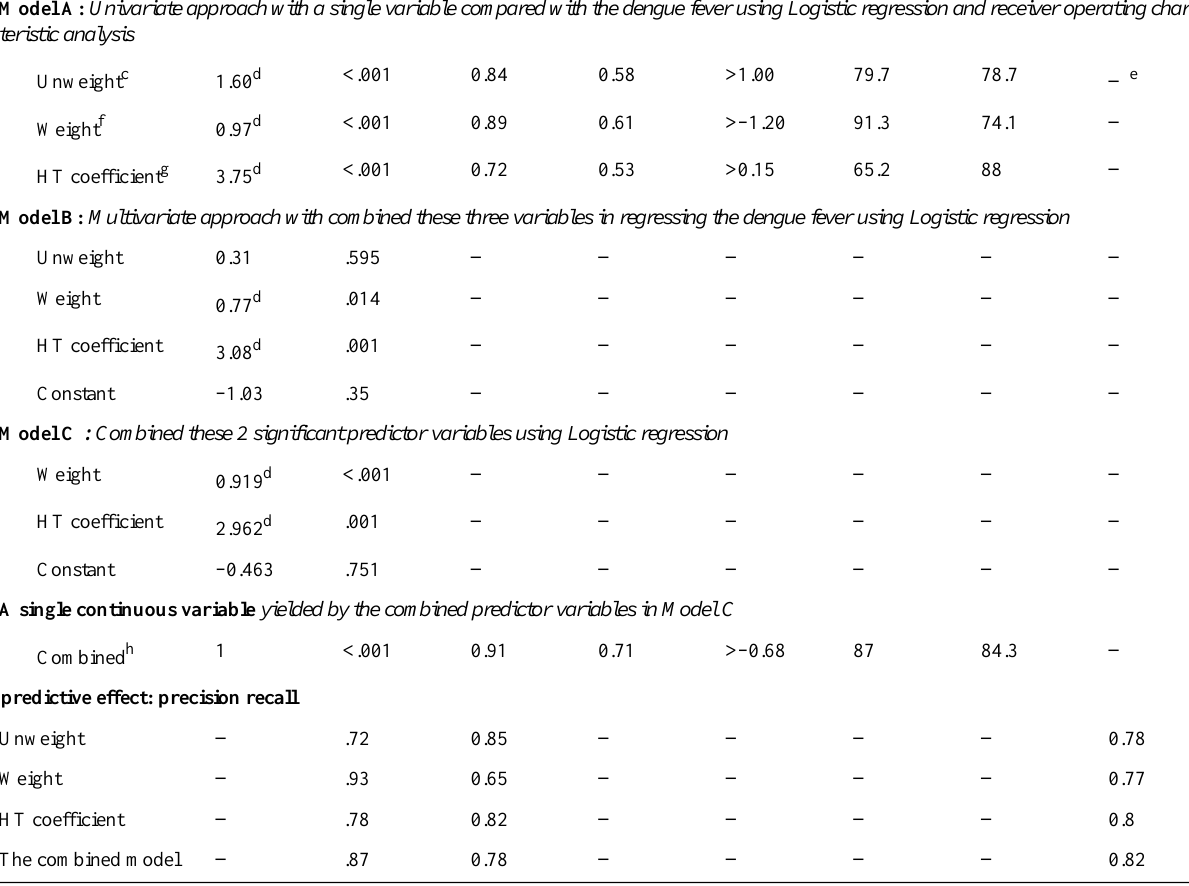
F-measureReceiver operating characteristic curve analysisLogistic regressionApproach and